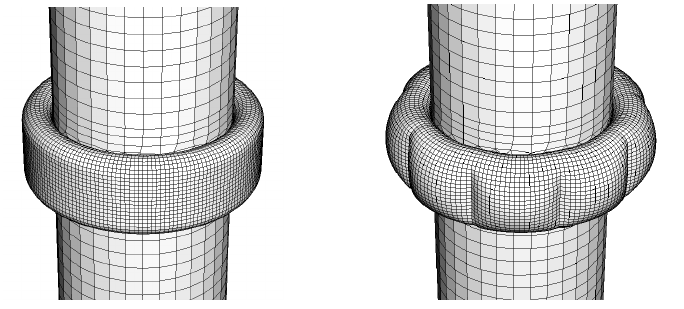
Fig. 1. Adaptive Inflatable Structure surrounding the wind turbine